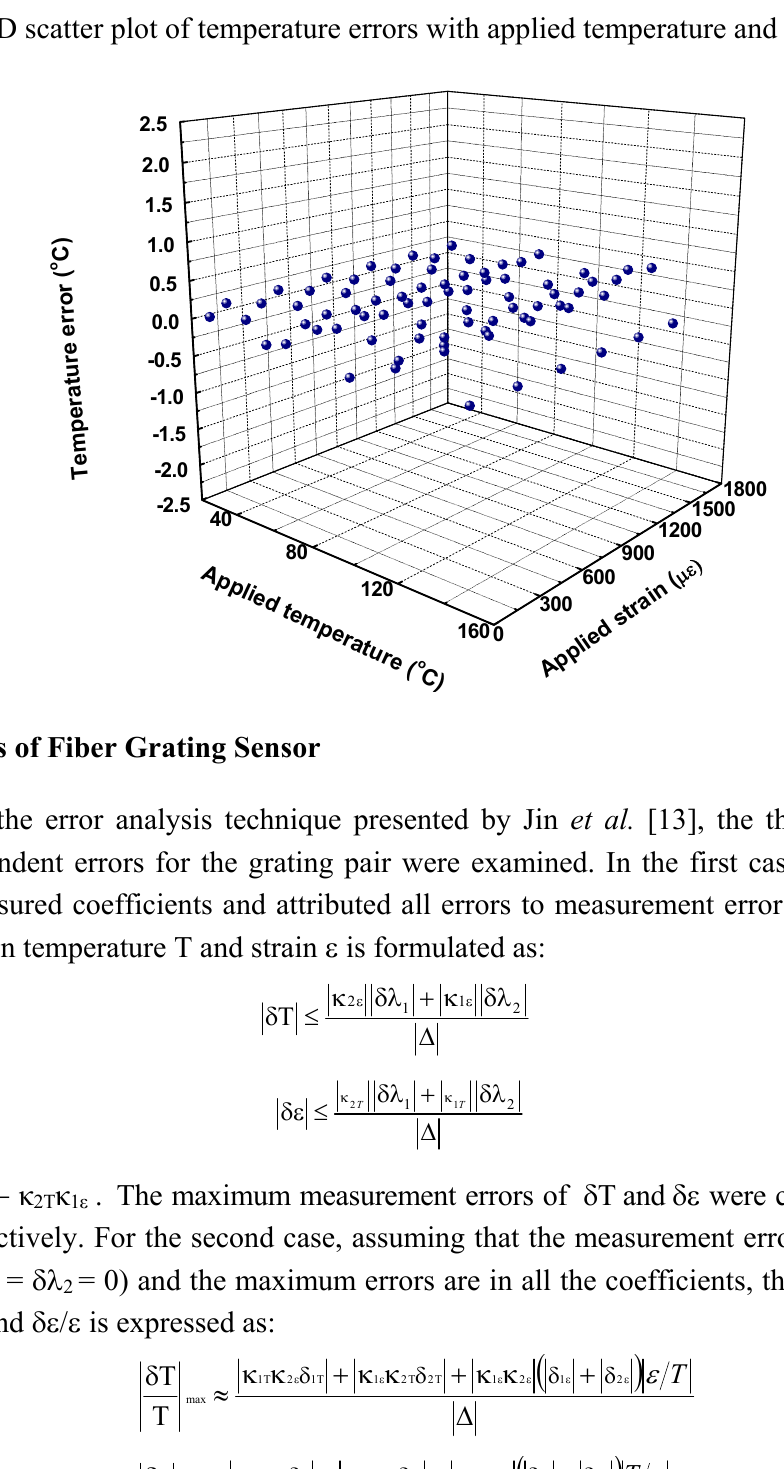
Figure 5. 3D scatter plot of temperature errors with applied temperature and applied